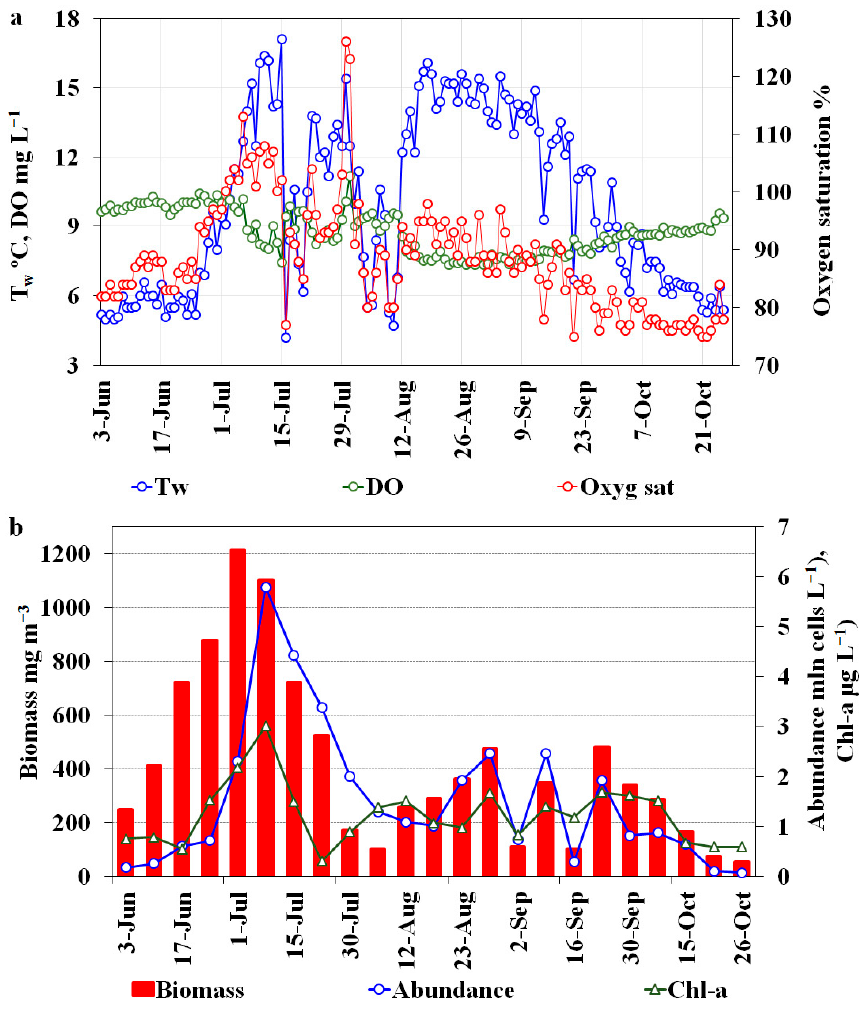
Figure 2. Water temperature (T w ), dissolved oxygen (DO), oxygen saturation ( a ), chlorophyll-a (Chl-a), phytoplankton biomass and abundance ( b ) in the littoral zone of Lake Baikal, 2020.